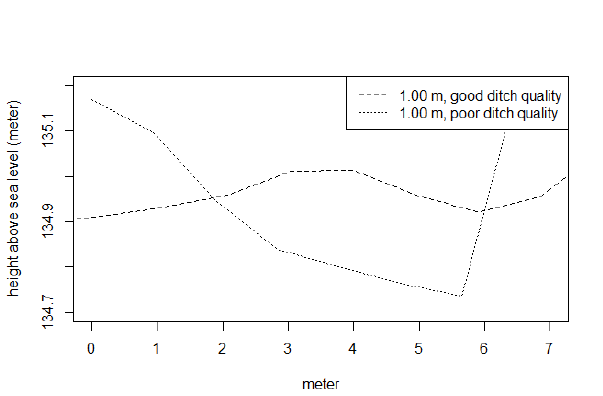
Figure 2. Cross-section of DEMs interpolated from low-pulse density ALS dataset on resolutions 1 m